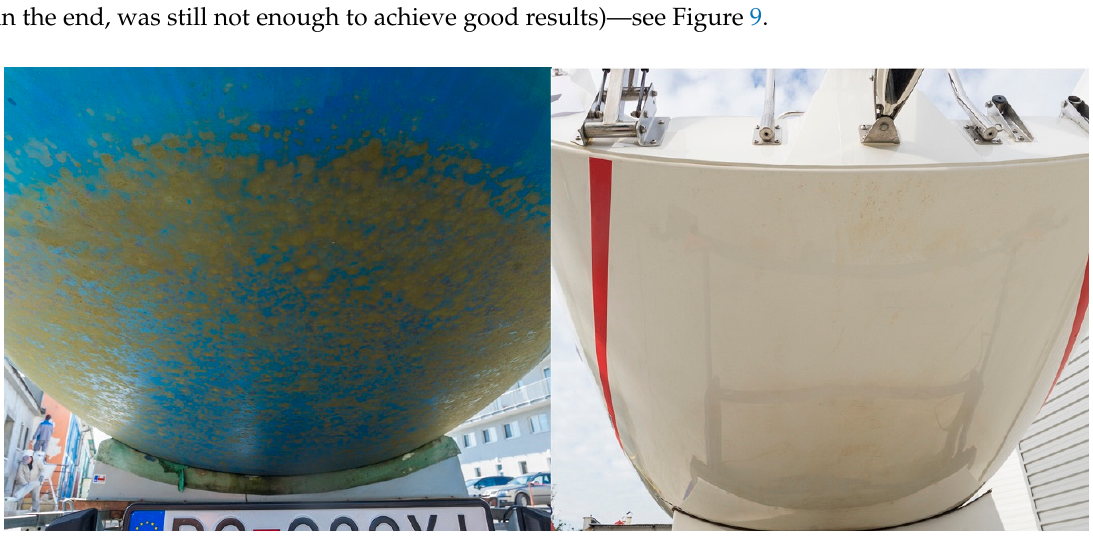
Figure 9. Comparison of the texture of the first sailboat (Saturn 720)—left; and the second one (Saturn 24RC)—right.